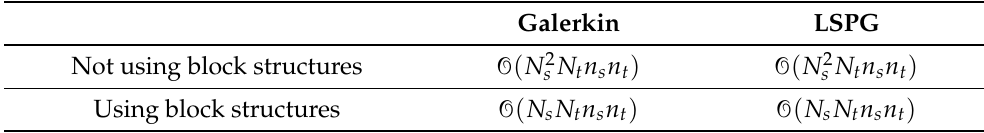
Table 3. Comparison of Galerkin and LSPG computational